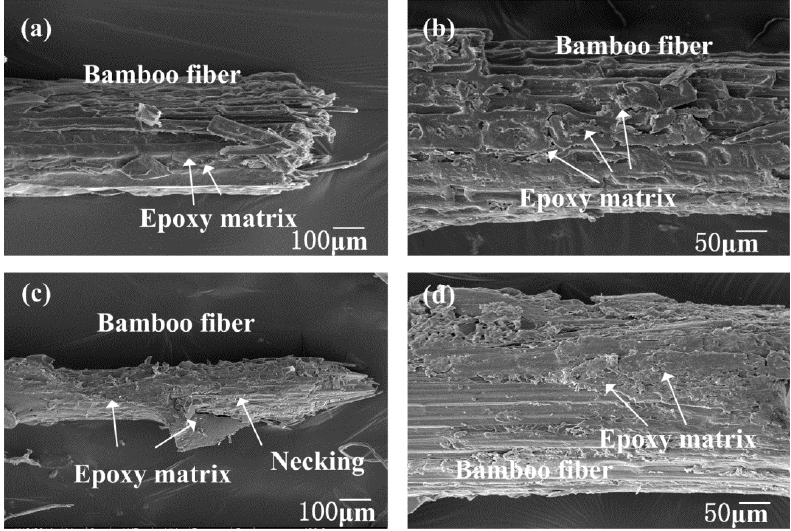
Figure 11. SEM images of bamboo fiber-reinforced epoxy after pull-out tests: ( a ) untreated bamboo fiber, ( b ) 2 wt.% NaOH treated bamboo fiber, ( c ) 6 wt.% NaOH treated bamboo fiber, ( d ) 10 wt.% NaOH treated bamboo